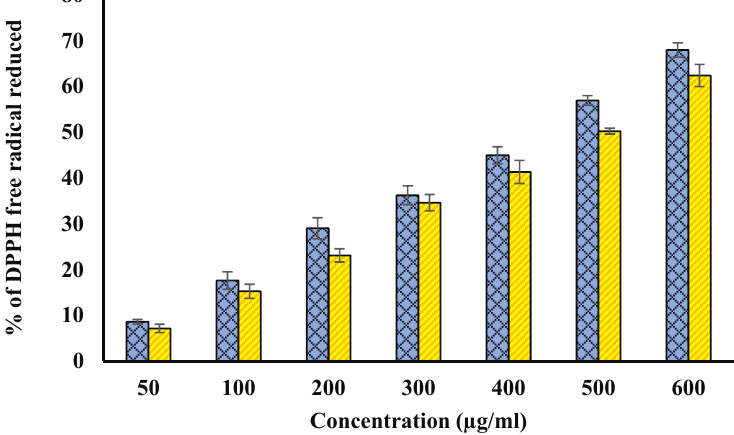
Figure 3. Blue bars show percentage of free radical reduced against fruit pulp concentration ( µ g/mL). However, yellow columns show the percentage free radical scavenging activity against seed extract concentration ( µ g/mL) of. The p -value significance was found to be less than 0.05 for this figure ( p <